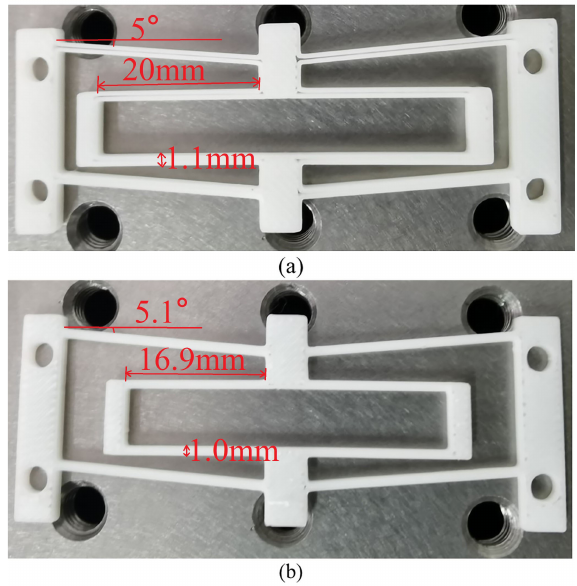
Figure 9. Comparison of the preliminary and optimized prototype ( a ) preliminary prototype, ( b ) op- timized